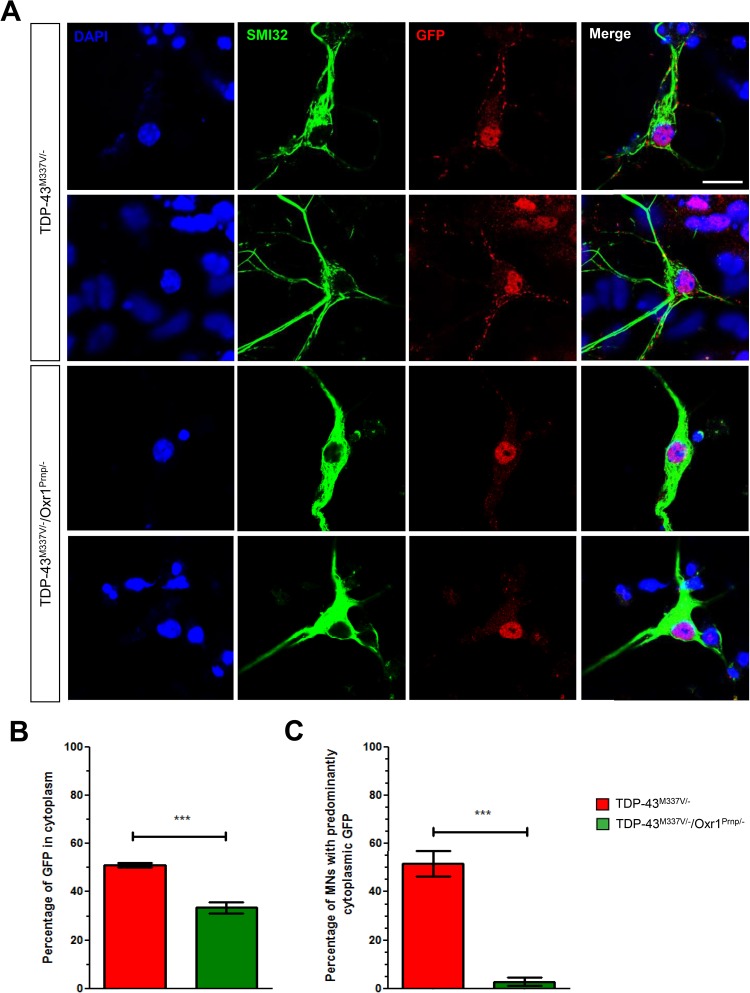
Genetic over-expression of Oxr1 reduces mislocalisation of mutant TDP-43 in TDP-43M337V/− primary motor neurons. (A) Representative images of SMI32-positive primary motor neurons from TDP-43M337V/− and TDP-43M337V/−/Oxr1Prnp/− mice stained with anti-GFP to quantify Ypet-tagged mutant TDP-43M337V. (B) Motor neurons from TDP-43M337V/−/Oxr1Prnp/− mice display a significant decrease in the proportion of cytoplasmic mutant TDP-43 compared to TDP-43M337V/− mice. (C) Motor neurons from TDP-43M337V/−/Oxr1Prnp/− animals show a significant decrease in the proportion of motor neurons with >50% cytoplasmic mutant TDP-43 compared with TDP-43M337V/− mice. Values are shown as the mean ± SEM. N = 45–60 motor neurons quantified per individual embryonic motor neuron preparation, N = 6 embryos quantified per genotype across two independent litters; ***P < 0.001, Unpaired student’s t-test. Scale bar: 20 μm.